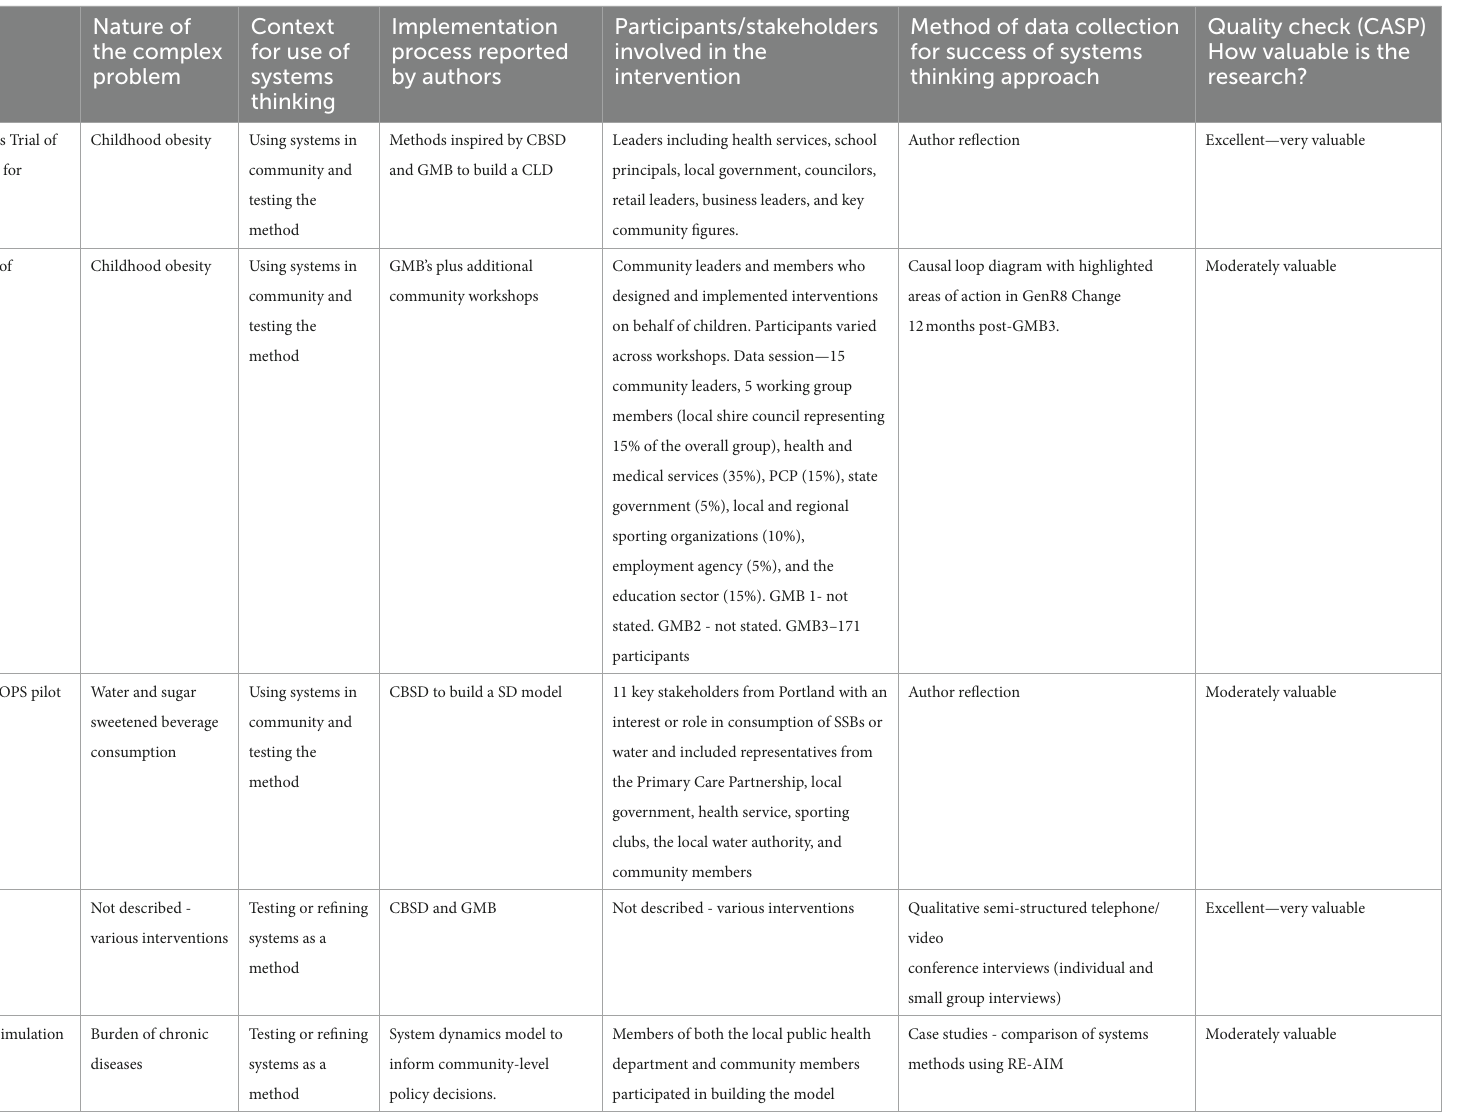
TABLE 3 Summary of articles and